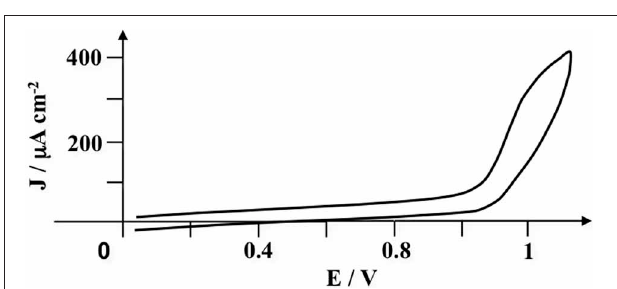
FIGURE 2 | Cyclic voltammogram recorded at a glassy carbon electrode of pyrrole-lactosyl (3 × 10 − 3 mol L − 1 ) in H 2 O + 0 . 1mol L − 1 LiClO 4 . Scan rate = 0 . 1V s − 1